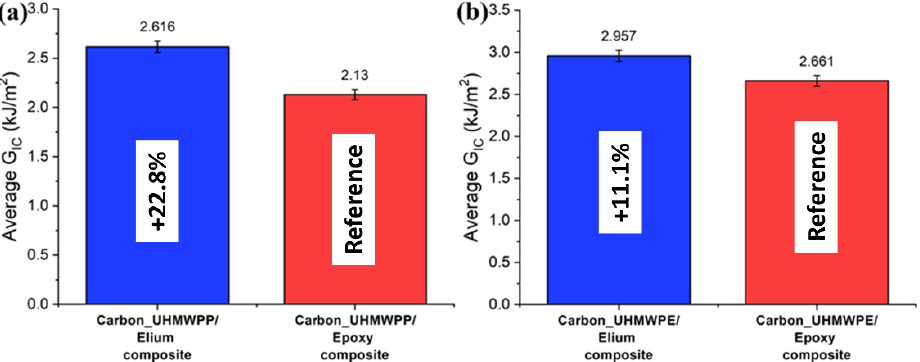
Figure 9. Average critical energy release rates for ( a ) Carbon_UHMWPP ( b ) Carbon_UHMWPE composites configurations .